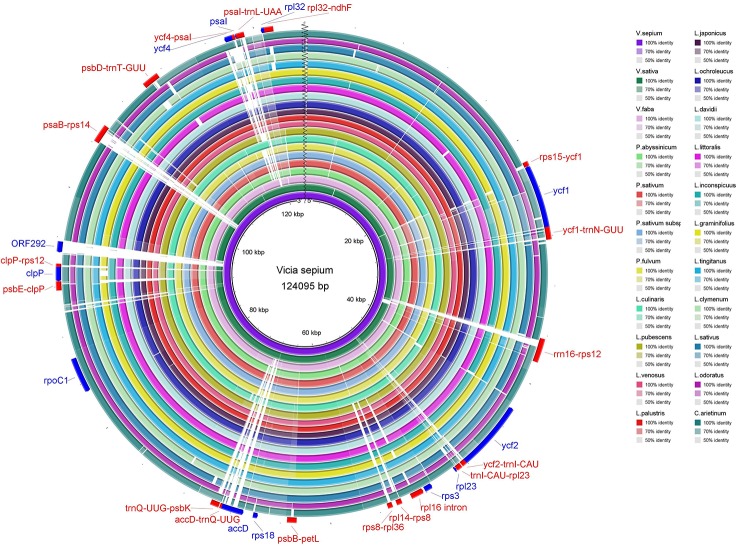
The sequence identity of 22 Fabaceae species. The inner circle is the reference genome. Next circles represent the sequence identity between V. sepium and 21 other species. The outermost circle corresponds to the protein-coding genes and intergenic spacer regions. Genes with clockwise arrows represent reverse strands, while genes with the counterclockwise arrow represent forward strands.